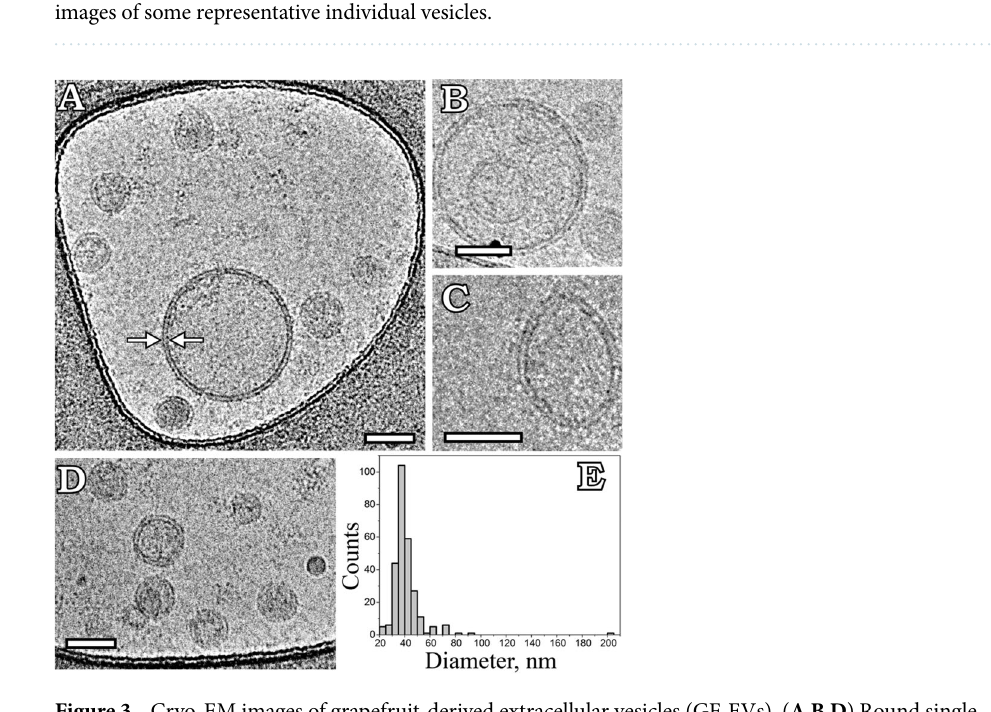
Figure 3. Cryo-EM images of grapefruit-derived extracellular vesicles (GF-EVs). ( A , B , D ) Round single vesicles; ( B ) double vesicle; ( C ) elliptical vesicle; ( E ) size distribution histogram. A total of 270 particles was analyzed. The arrows depict a lipid bilayer membrane of vesicle. Scale bars are 50